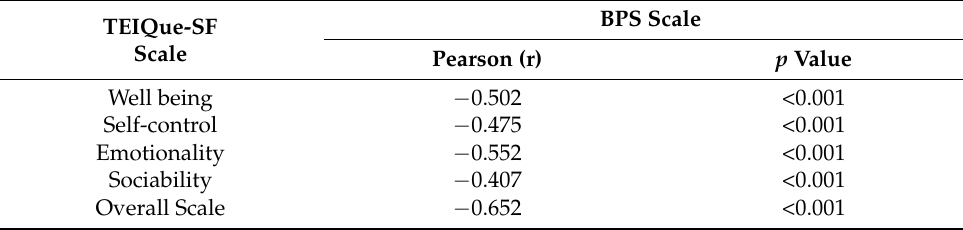
Table 3. Correlation between TEIQue-SF and BPS of Nurses ( n =